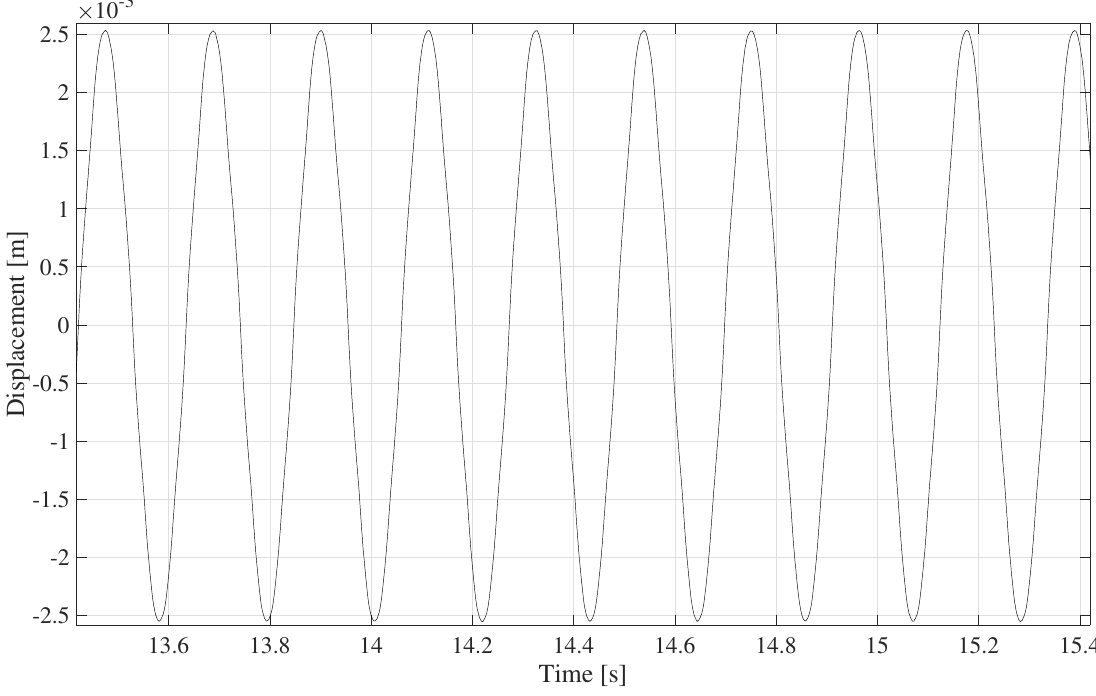
Figure 10. Target displacement in time, measured by the